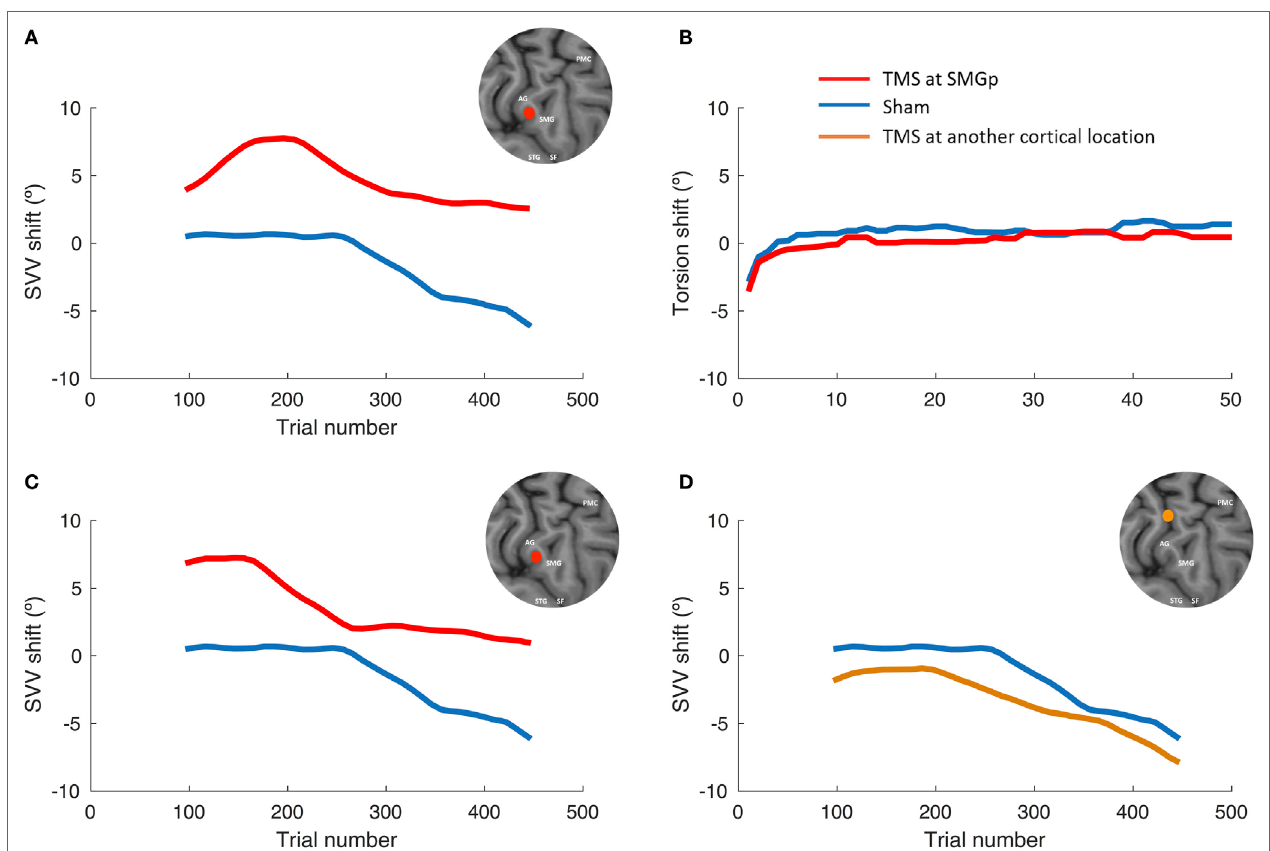
FigUre 3 | SVV and ocular torsion shifts following TMS and sham stimulation in a single participant. (a) SVV shift at the supramarginal gyrus (SMGp) (red) is shown along with the SVV shift from the sham session (blue). In both traces, there is a leftward drift over time (i.e., the head tilt direction), but the SVV shift from TMS is larger and it is in the opposite direction of the head tilt. (B) Ocular torsion shift is shown for SMGp (red) along with the sham session (blue). There is no significant difference between the sham and TMS sessions. (c) SVV shift from the localization session (first TMS session) at SMGp (red) is shown along with the sham session (blue). The SVV shift is comparable to the second TMS session at SMGp (a) , which shows a reproducible TMS effect at SMGp. (D) SVV shift at another cortical location (orange) is shown along the sham session (blue). Here, both traces also drift over time toward the left side (i.e., the head tilt direction); however, the SVV shift from TMS is smaller and it is in the same direction as the head